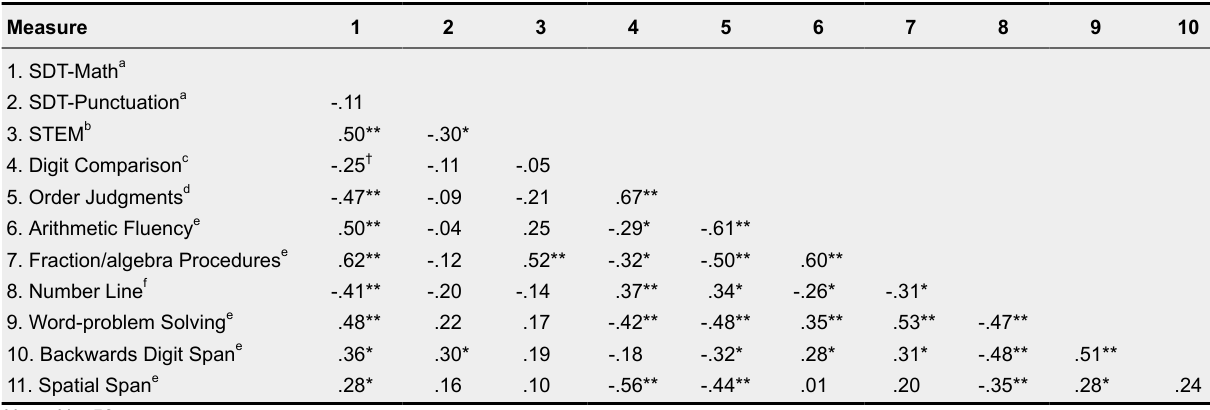
Zero-Order Correlations Among the Math Outcomes, Experimental Tasks and Control Variables